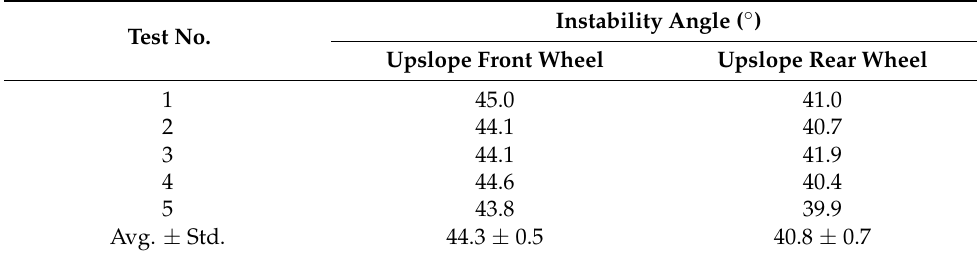
Table 6. Instability angle for upslope front and rear